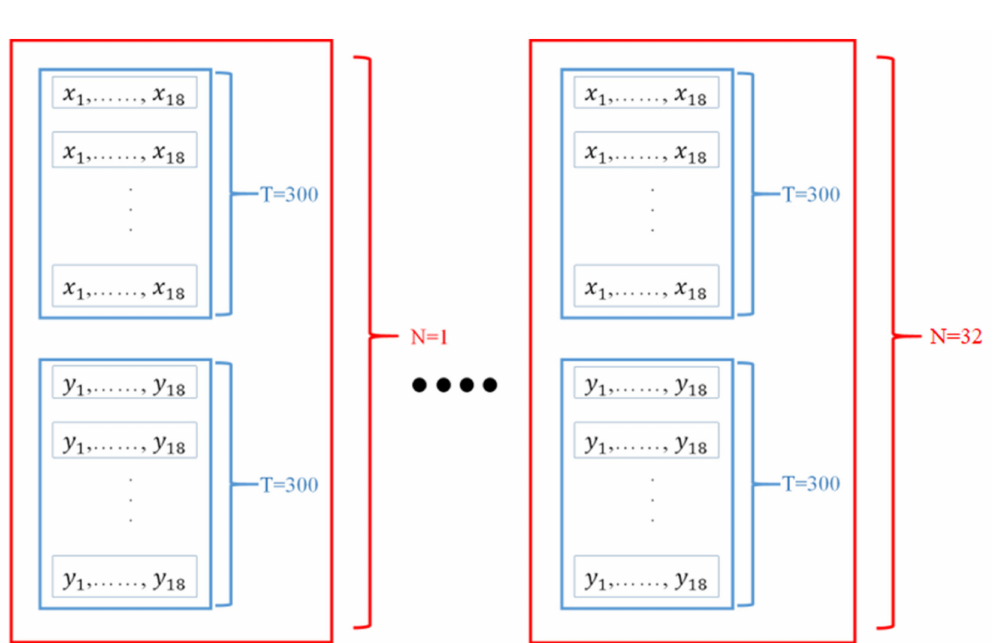
Figure 3. One feature built by the joint data, skeleton data, joint-motion data, or skeleton-motion data, with the size of 600 ×